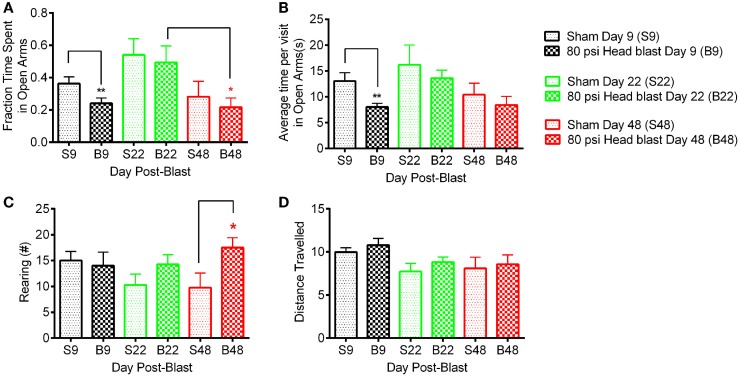
Blast-exposed rats exhibit anxiety-like behavior 9 days post-blast and hyper-arousal 48 days post-blast. A total of 80 psi head blast rats tested on day 9 spent significantly less time in the open arms (A) and less average time in each visit to the open arms (B) compared to the sham rats (un-paired Student’s t-test: **p < 0.01, n = 11 blast and 10 sham). Hyper-arousal was noted in 80 psi head blast rats, which exhibited excessive rearing compared to sham rats (C) on day 48 post-blast compared to sham rats (two-way repeated measures ANOVA with Bonferroni post hoc analysis: *p < 0.05, n = 8/group). Rat mobility/motor function was not affected by the blast overpressure wave as both groups traveled similar distances (D) on days 9, 22, and days 48 post-blast/sham. Data are presented as mean ± SEM.